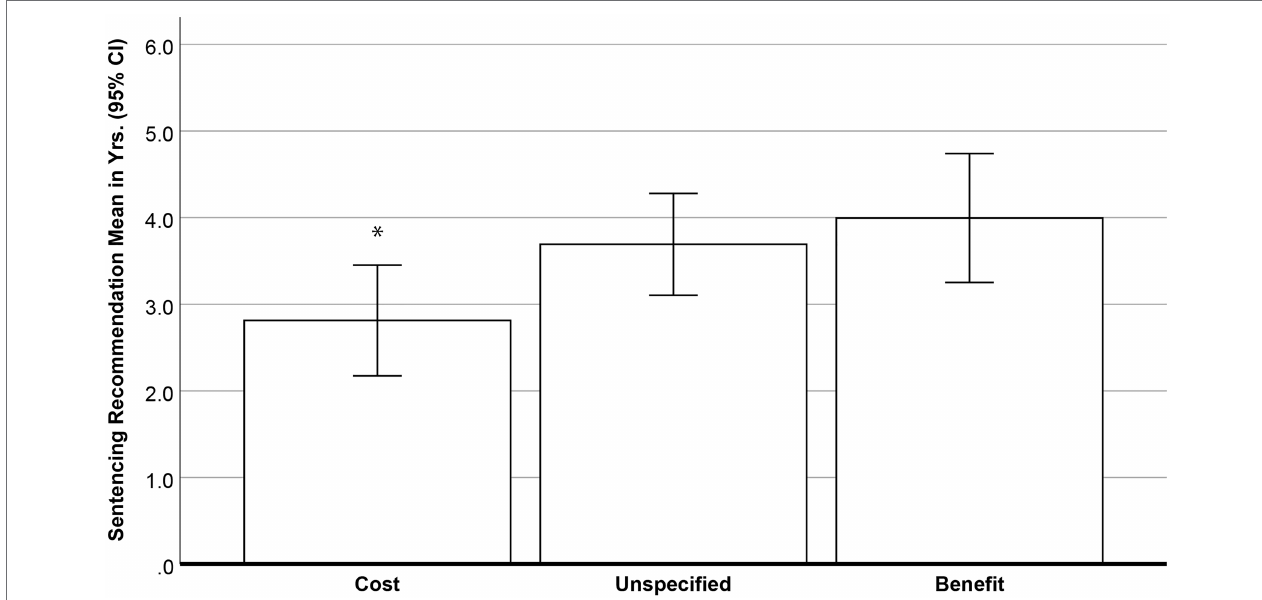
FIGURE 1 | Mean objective sentencing recommendations when information about the costs ( n = 61) or benefits ( n = 45) of incarceration was present or unspecified ( n = 72). Cost < Unspecified*; Cost < Benefit*; * p <